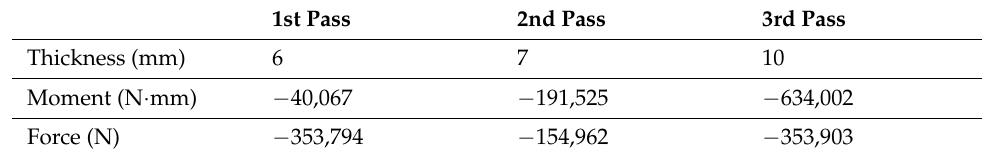
Table 4. Equivalent load by pass.